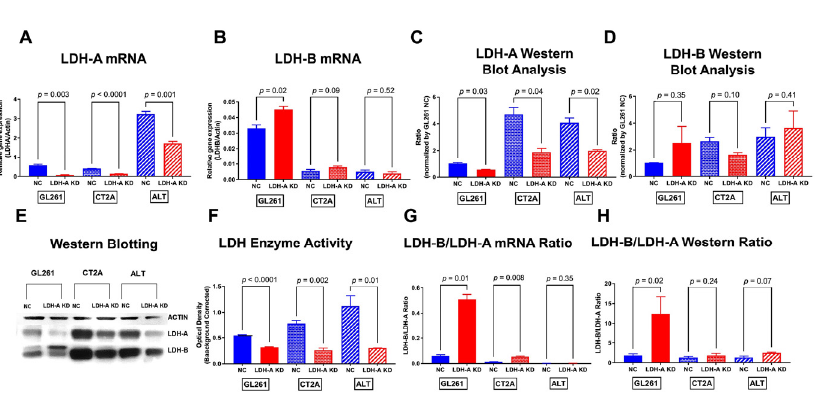
Figure 1. Characterization of murine glioma cell lines (GL261, CT2A and ALTS1C1) following LDH-A shRNA knock-down . LDH-A and LDH-B mRNA levels by ddPCR ( A , B ); protein expression on Western blot analyses ( C – E ); and LDH enzyme activity ( F ) in control NC and LDH-A KD cell lines (GL261, CT2A, ALTS1C1). LDH-B/LDH-A mRNA expression ratios ( G ) and LDH-B/LDH-A Western blot ratios ( H ) for control NC and LDH-A KD cell lines (GL261, CT2A, ALTS1C1). n = 3, ± SEM. The native Western blot for Panel E is shown in the Supplement (Figure S4).